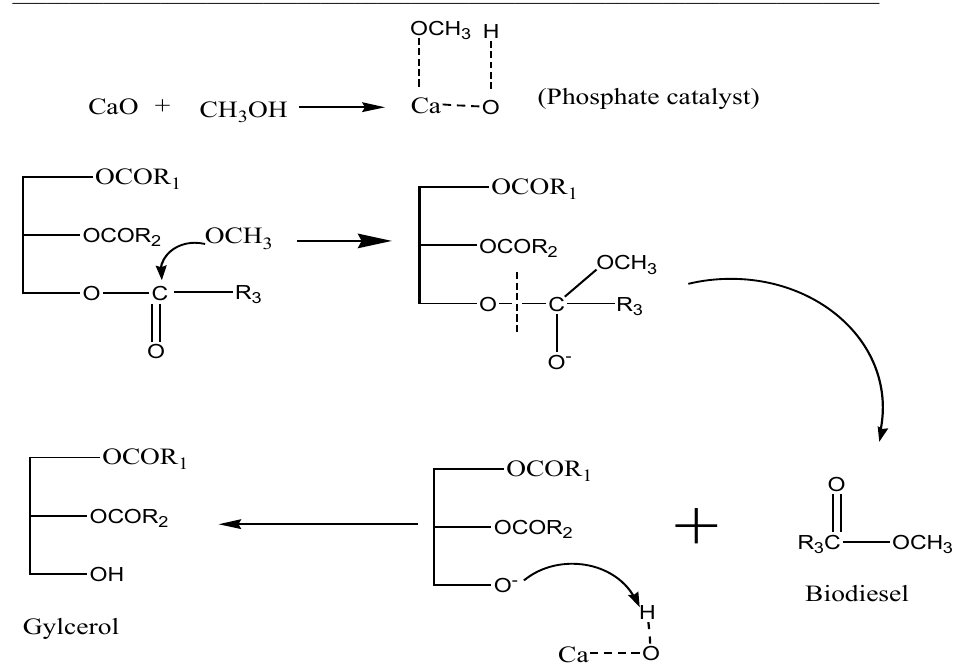
Fig. 5. The reaction mechanism of transesterification using calcined phosphate